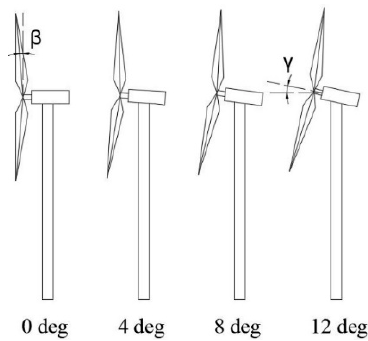
Appl. Sci. 2020 , 10 , x FOR PEER REVIEW Figure 7. Structure of the wind turbine at different tilt angles. Figure 7. Structure of the wind turbine at di ff erent tilt angles.